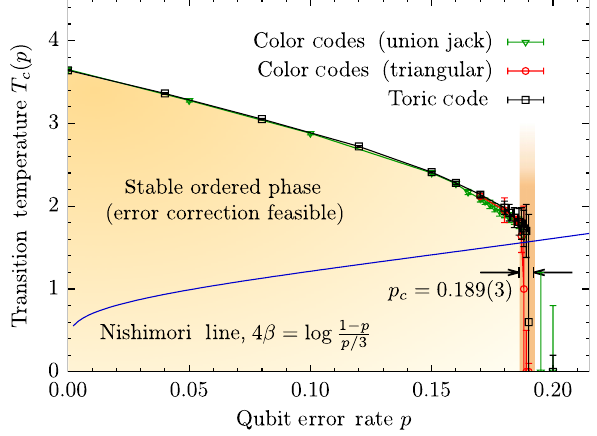
FIG. 1. Phase boundary estimated from Monte Carlo simula- tions for the estimation of the error threshold of the toric code, as well as two realizations of color codes (see text). The error threshold p c corresponds to the point at which the Nishimori lines intersects the phase boundary. Remarkably, the phase boundaries for all three codes agree within error bars. The stable ordered phase corresponds to the regime where quantum error correction is feasible.